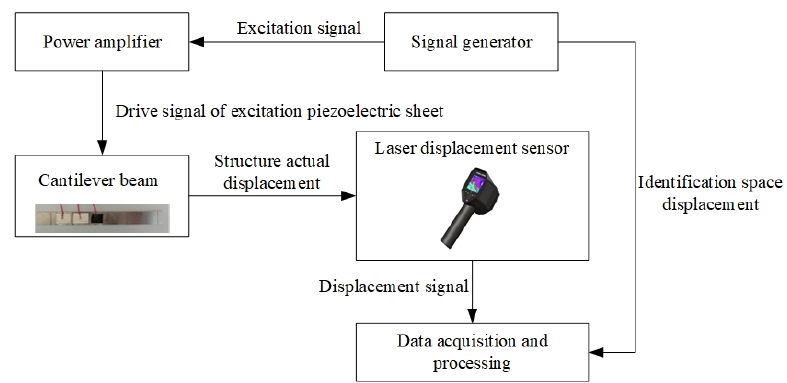
Figure 6. Experimental schematic diagram.